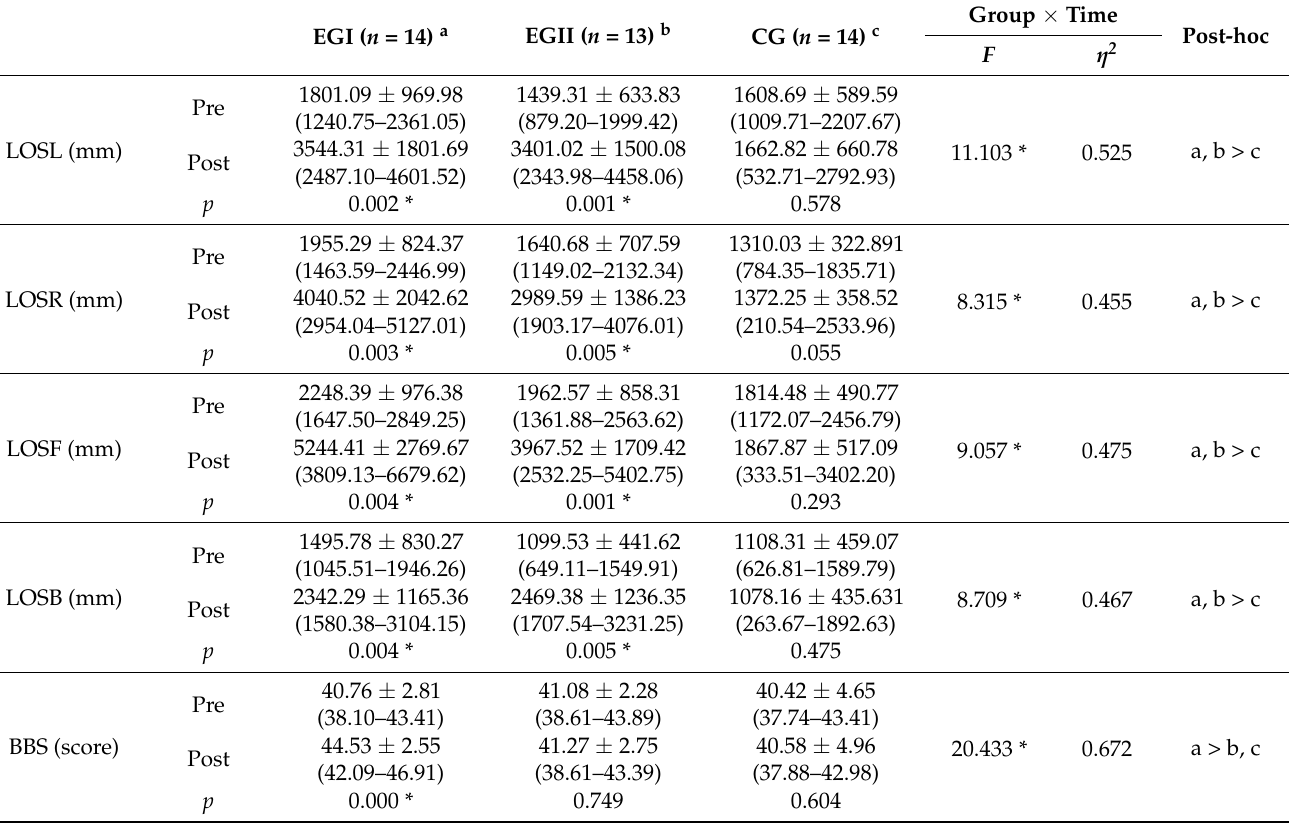
Table 2. Comparison of balance function for each